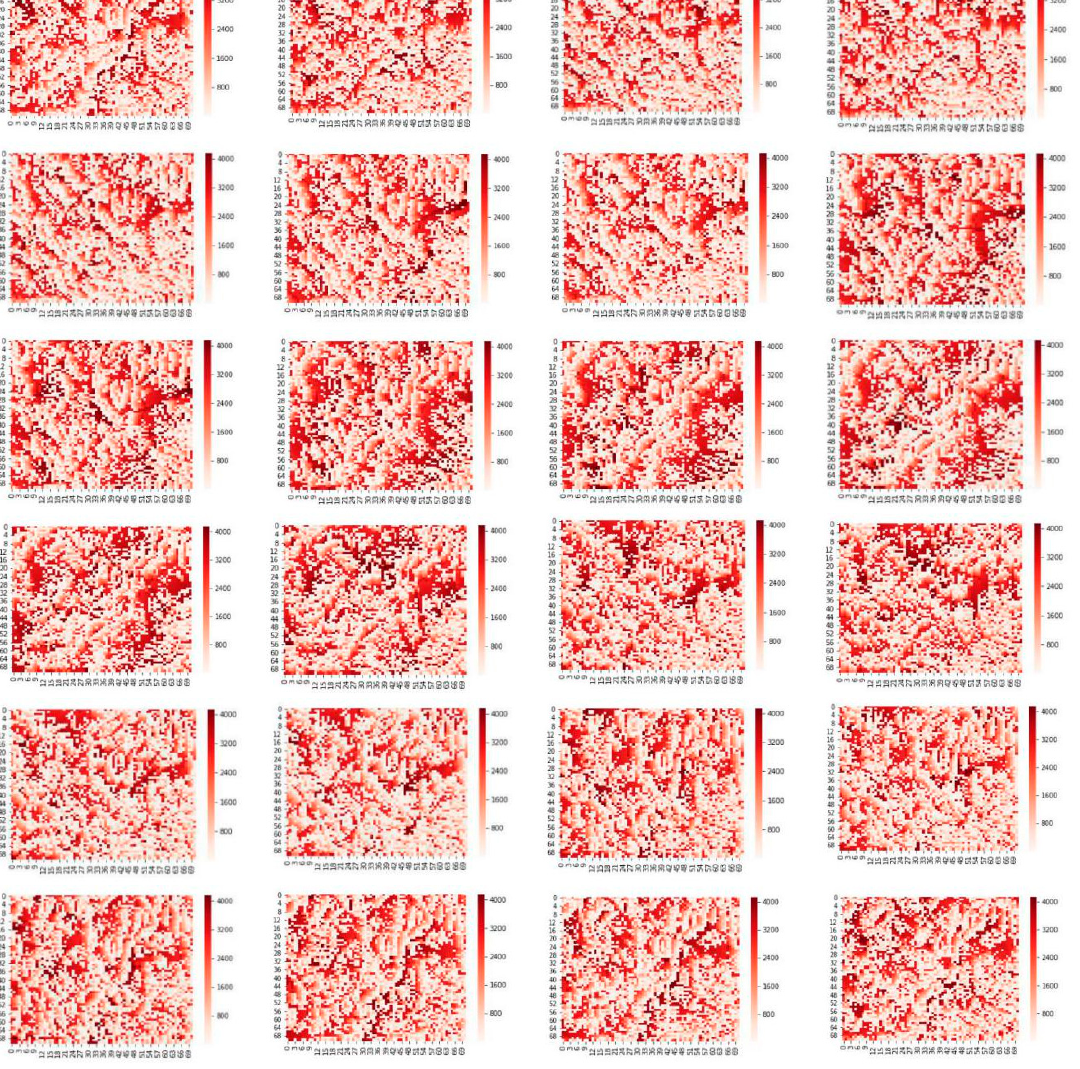
Figure A1. The heatmaps of 24 subdatasets.